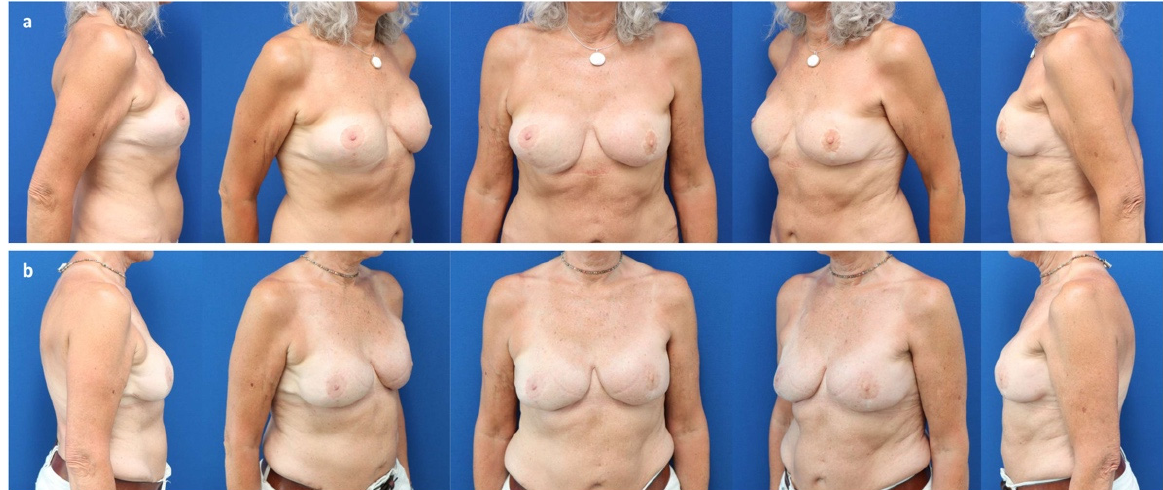
Figure 7. ( a ) A 59-year-old patient after a bilateral skin reducing mastectomy for invasive lobular carcinoma (pT3 pN2 (10/10) M0) of the left breast and immediate subpectoral implant-based recon- struction elsewhere, followed by adjuvant radiotherapy. Exchange of implants with microvascular flaps from the abdomen (DIEP). Salvage of the breast pocket with an implant on the right for flap failure. Note the caudal implant displacement and asymmetry of breast shape. ( b ) Three years after a pocket change from subpectoral to prepectoral, exchange of the implant (Motiva Ergonomix ® ERSM 400 cc), reconstruction of the inframammary fold, and autologous fat grafting to the mastectomy flap (220 cc).